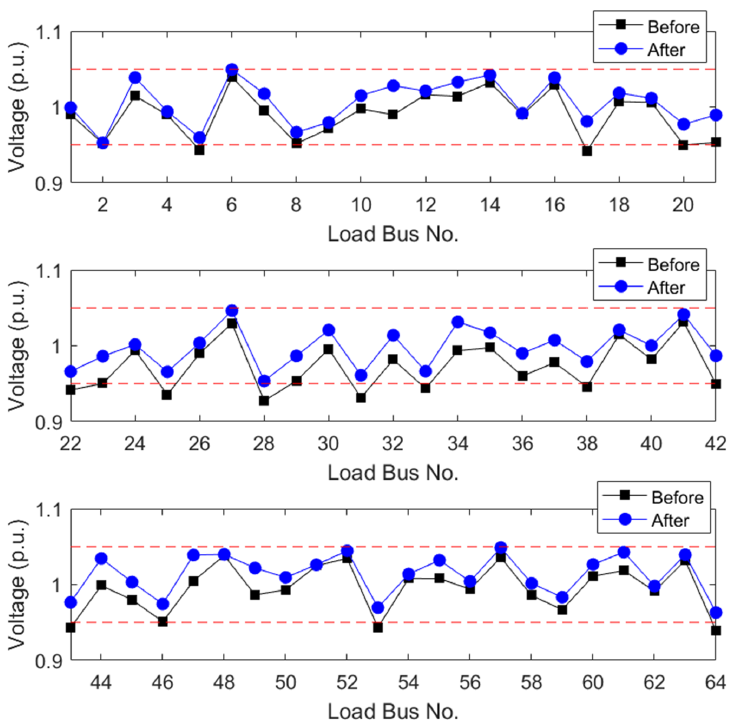
Figure 9. Load bus voltage profile of Case 2 for IEEE 118 ‐ bus.